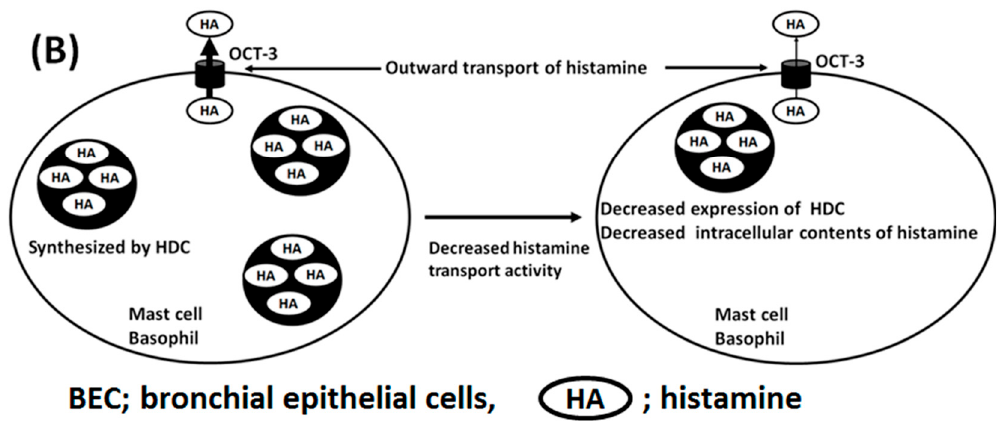
Figure 4. Scheme of histamine transport system through OCT-3. ( A ) Inward transport of histamine in bronchial epithelial cells. Genetic polymorphisms of OCT-3 affect the inward transport activity of histamine, resulting in the increased amounts of histamine in extracellular space and possibly confer stronger stimulation on H1R and induce contraction of bronchial smooth muscle cells. ( B ) Outward transport system of histamine through OCT-3 in professional histamine-producing cells (mast cells and basophils). Genetic polymorphisms of OCT-3 affect the outward transport activity of histamine, resulting in the decreased amounts of histamine contents in the vesicles through homeostatic